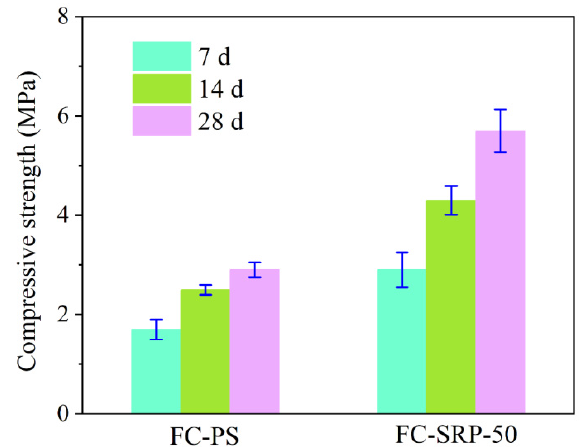
Figure 8. Compressive strength of foam concretes.